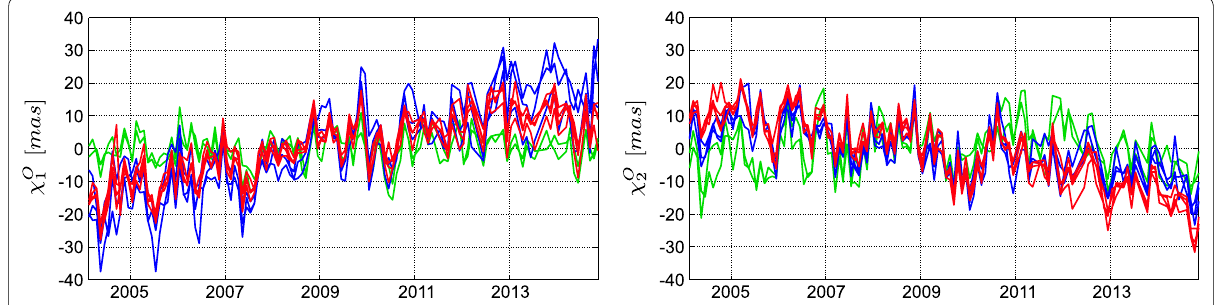
Fig. 9 Mass-related oceanic polar motion excitation functions derived from GRACE RL05 (blue) and RL06 (red) data as well as from the ocean model ECCO and the model results from ESMGFZ (OAM